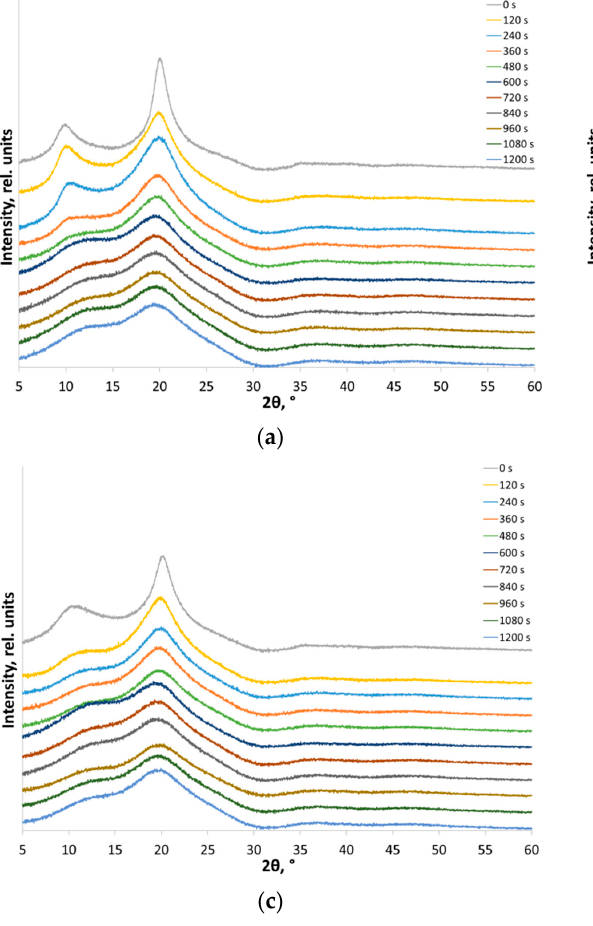
Figure 4. X-ray powder diffraction patterns of chitosan (( a ) high MW, ( b ) medium MW, ( c ) low MW) subjected to mechanical treatment in a planetary ball mill for 0–1200 s. The curves are shifted for clarity as indicated. Table 1. The crystallinity indices of the initial and mechanically amorphized chitosan with different molecular